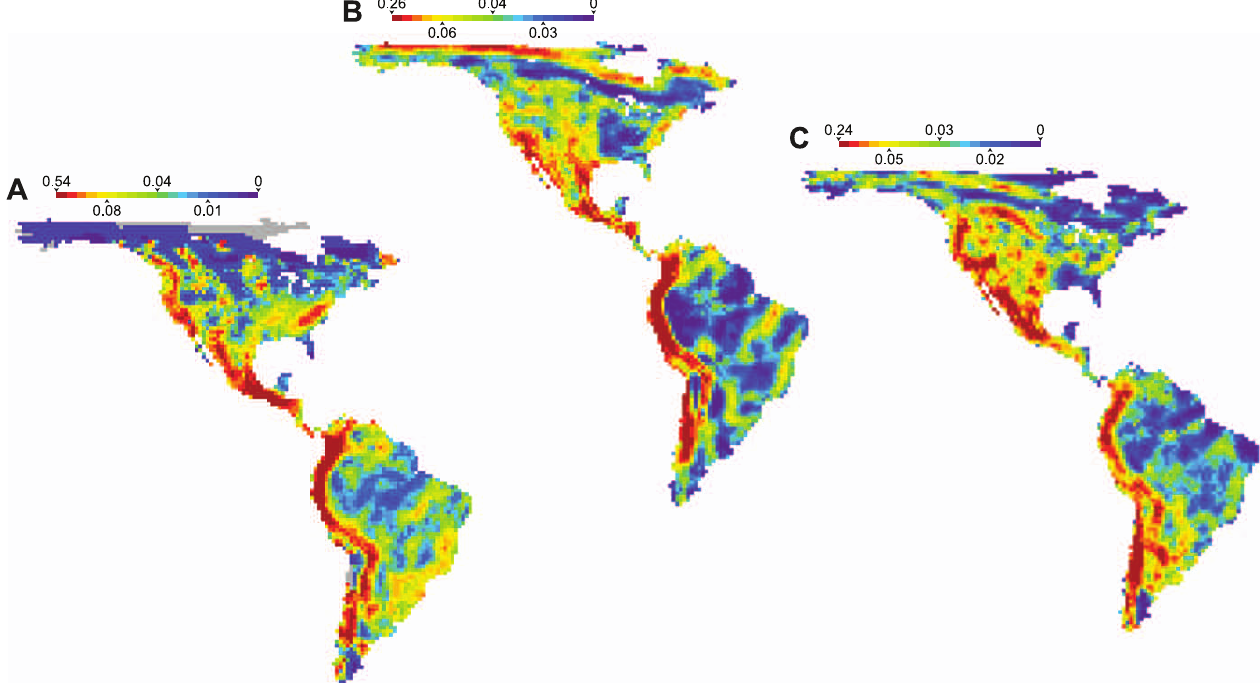
Figure 1. Beta-Diversity of Amphibians, Birds, and Mammals Mapped Continuously across the Continental Western Hemisphere Beta-diversity ( b sim-d ) values for each taxon are divided into 20 quantiles, represented by warm (higher b sim-d ) to cool (lower b sim-d ) colors. The scale accompanying the color ramp for each taxon shows minimum, first quartile, median, third quartile, and maximum values of b sim-d . Gray grid cells do not contain amphibian species. (A) Amphibians. (B) Birds. (C) Mammals.